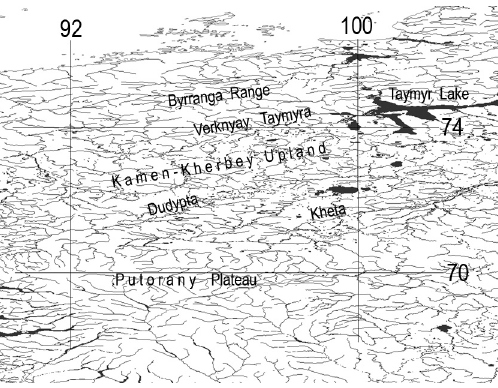
Fig. 11. Map of Kamen-Kherbey Uplands calving